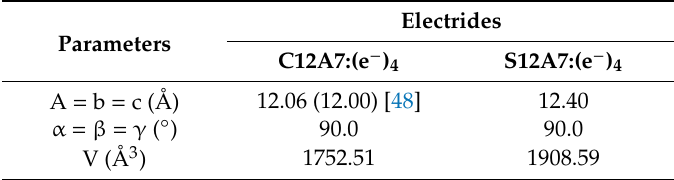
Figure 1. ( a , b ) Relaxed structures of C12A7:(e − ) 4 and S12A7:(e − ) 4 , respectively, and ( c , d ) corresponding relaxed cages occupied with extra-framework electrons. Cage pole Ca–Ca and Sr–Sr distances are calculated to be 5.70 Å and 5.73 Å in C12A7:(e − ) 4 and S12A7:(e − ) 4 , respectively. Table 1. Calculated lattice parameters of C12A7:(e − ) 4 and S12A7:(e − ) 4 . Available experimental values are shown in parentheses.